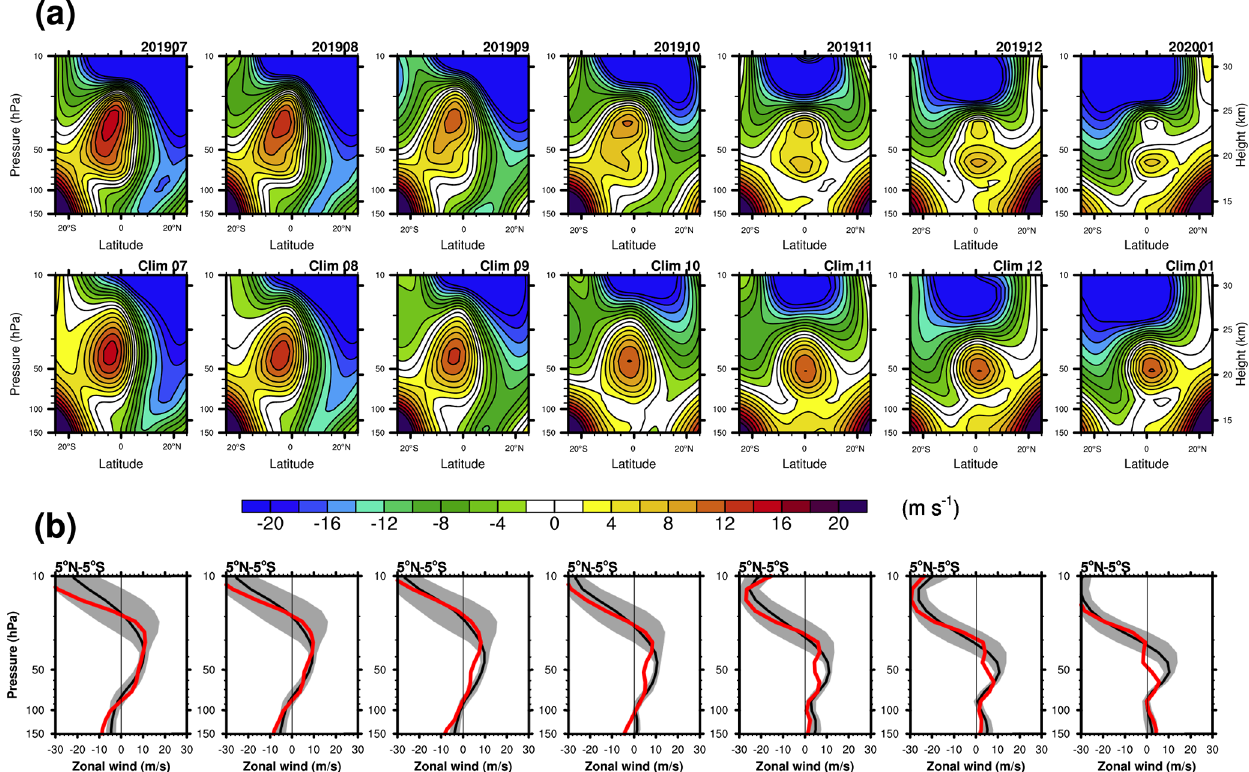
Figure 1. (a) Zonal-mean zonal wind in a latitude–height cross section during July–January for the disruption period (2019/20) and (b) the climatology. (b) Zonal-mean zonal wind averaged for 5 ◦ N–5 ◦ S during July–January for the disruption period (2019/20; red) and the climatology (black) overlaid with the ± 1SD (gray shading). The climatology corresponds to the westerly QBO years (Sect.